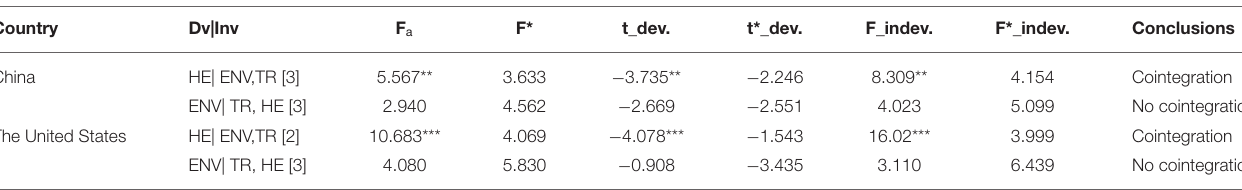
TABLE 3 | Cointegration between variables.